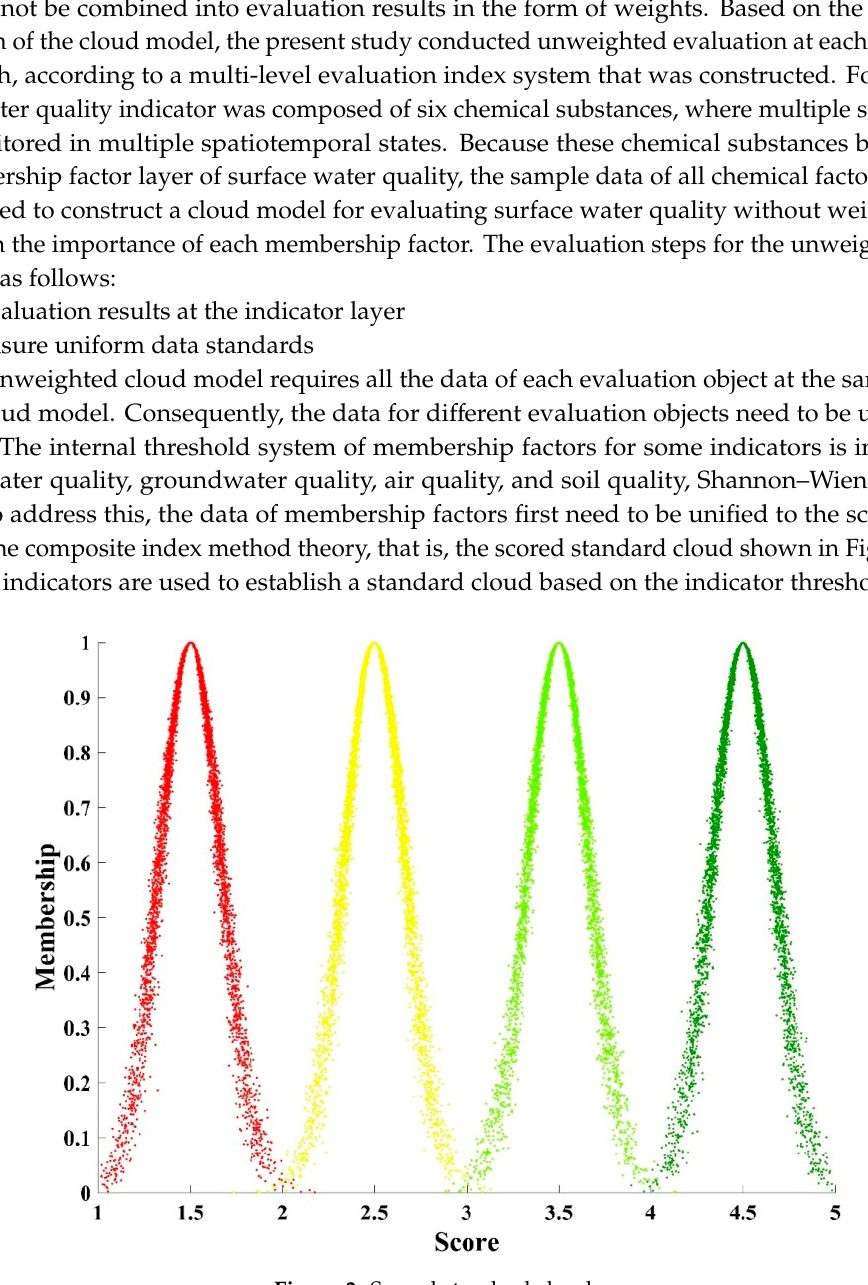
Figure 4. Modified scored standard cloud.